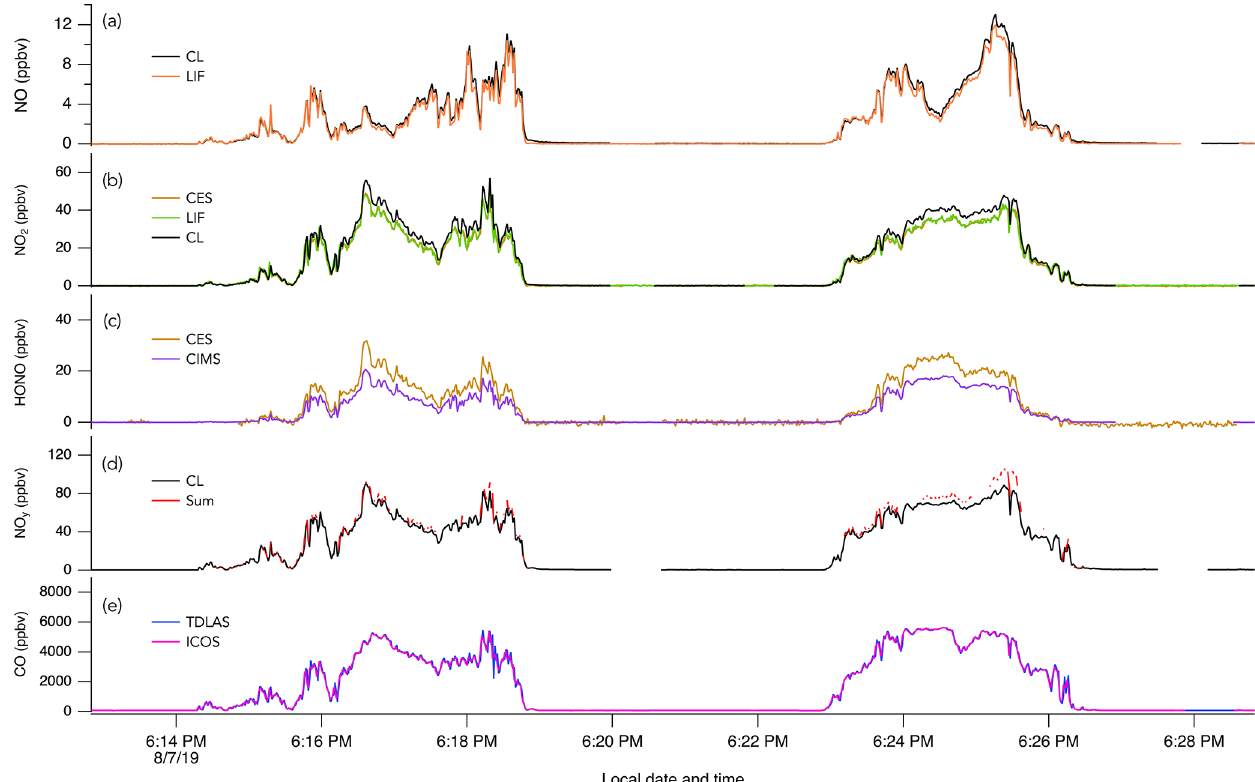
Figure 3. The 1s measurements of (a) NO, (b) NO 2 , (c) HONO, (d) NO y , and (e) CO during two crosswind plume transects of smoke from the Williams Flat fire on 7 August 2019. The plume transects were chosen due to the significant enhancement of all species at that time. Note that in panel (b) the NO 2 trace from the CES instrument is hidden behind the NO 2 trace from the LIF